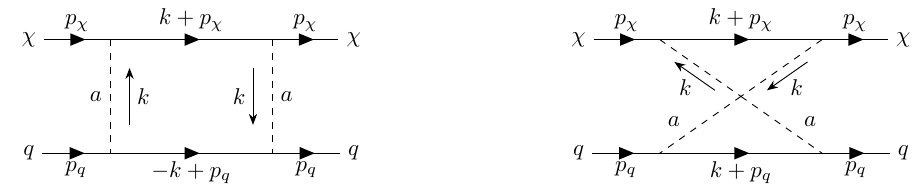
Figure 10 . Box and corresponding crossed diagram including visualization of the momentum (cid:13)ow in the limit of no momentum